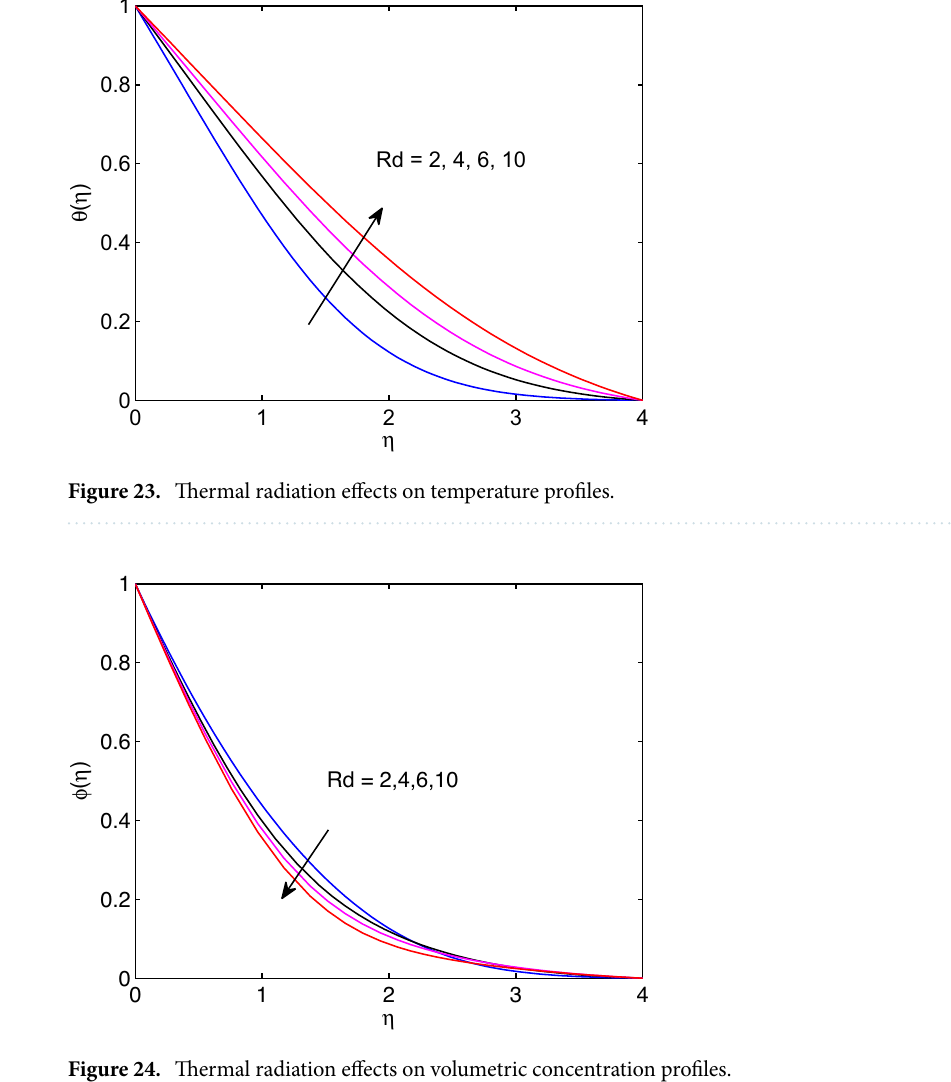
Figure 24. Thermal radiation effects on volumetric concentration